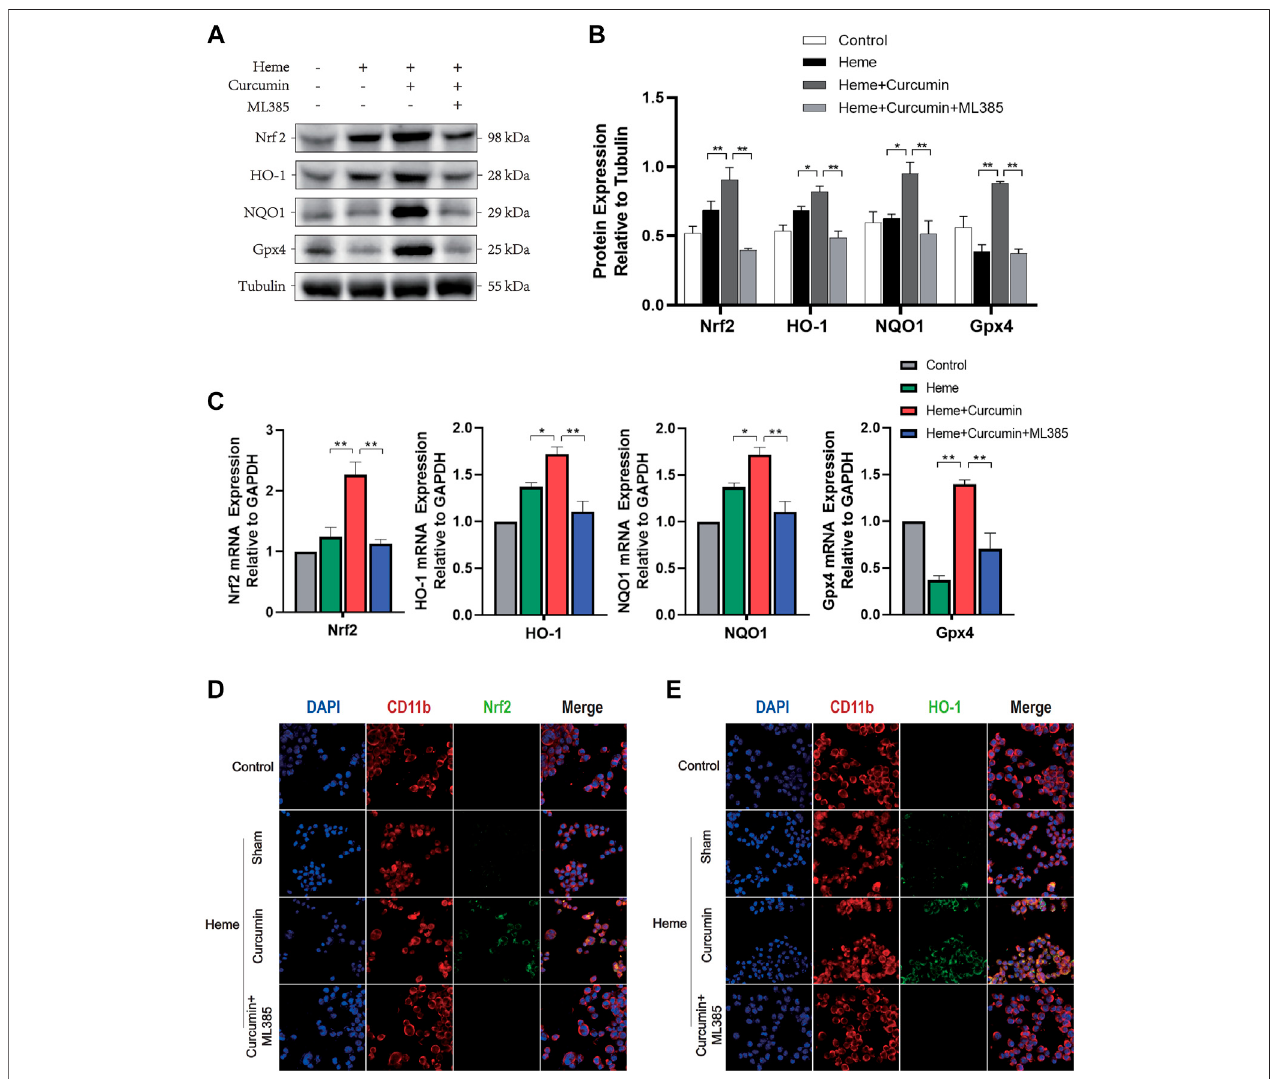
FIGURE3 | Curcumin could activate the Nrf2/HO-1 pathway in HAPI cells. (A) Western blot analysis ofeach group ofHAPI cells. (B) ImageJ software was used to furtherquantifythegrayvaluesofWesternblotbands. (C) TheexpressionoftheNrf2,HO-1,NQO1,andGpx4wasdetectedusingRT – qPCRandcomparedwiththatof an internal reference gene (GAP). (D) The HAPI cell membrane protein CD11b was labeled with Texas Red, and Nrf2 was marked by FITC. (E) The HAPI cell membrane protein CD11b was labeled with Texas Red, and HO-1 was marked by FITC. The data are shown as the means ± SD of n = 3 samples/group and at least three independent experiments were performed. Statistical analyses were conducted using two-way ANOVA. *, p < 0.01 and **, p < 0.01.